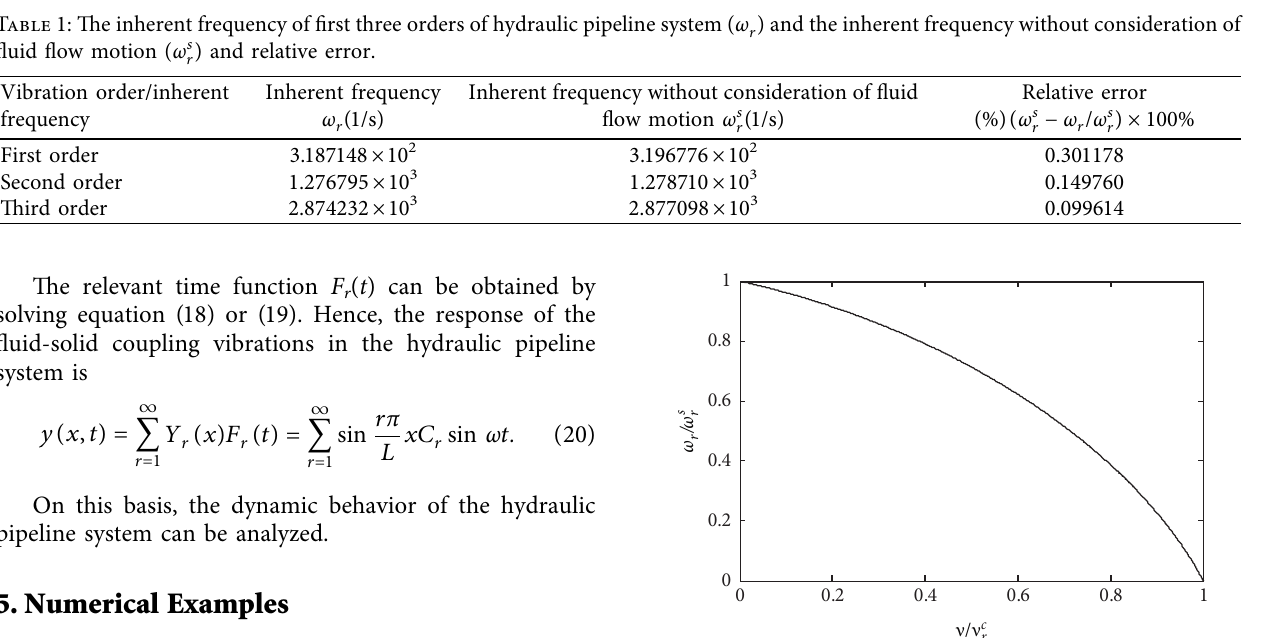
r ) and the inherent frequency without consideration of